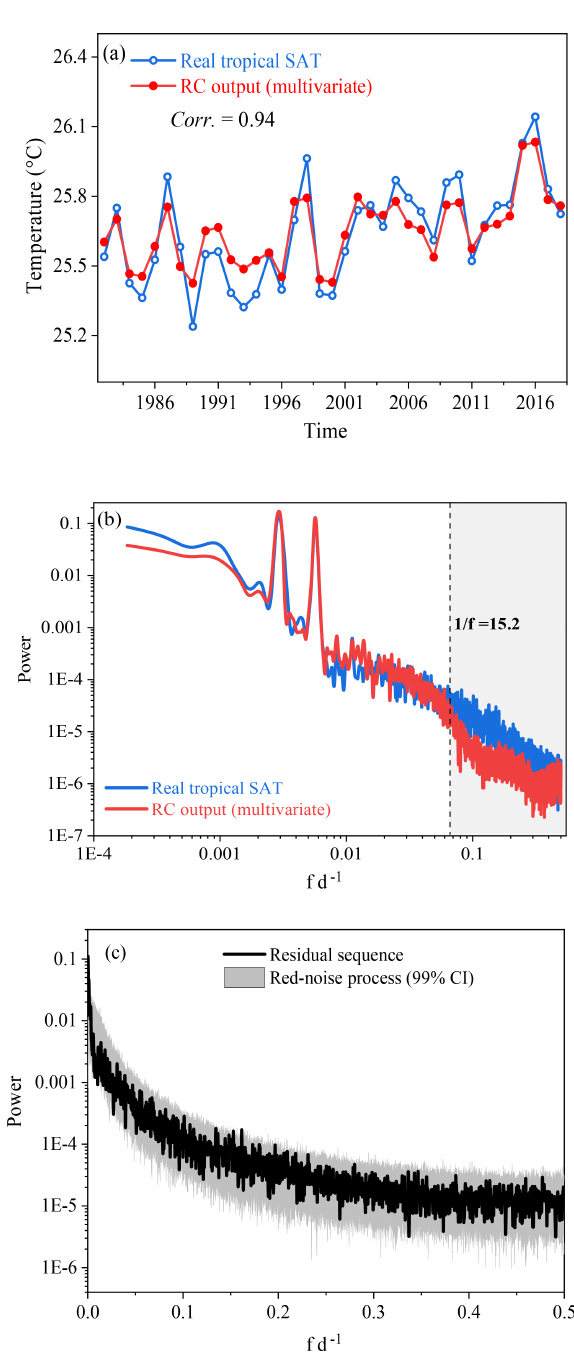
Figure 12. (a) Comparison of the annual mean values between the reconstructed TSAT and real TSAT. (b) Comparison of the power spectrum between the reconstructed TSAT and real TSAT. (c) A red-noise test for residual